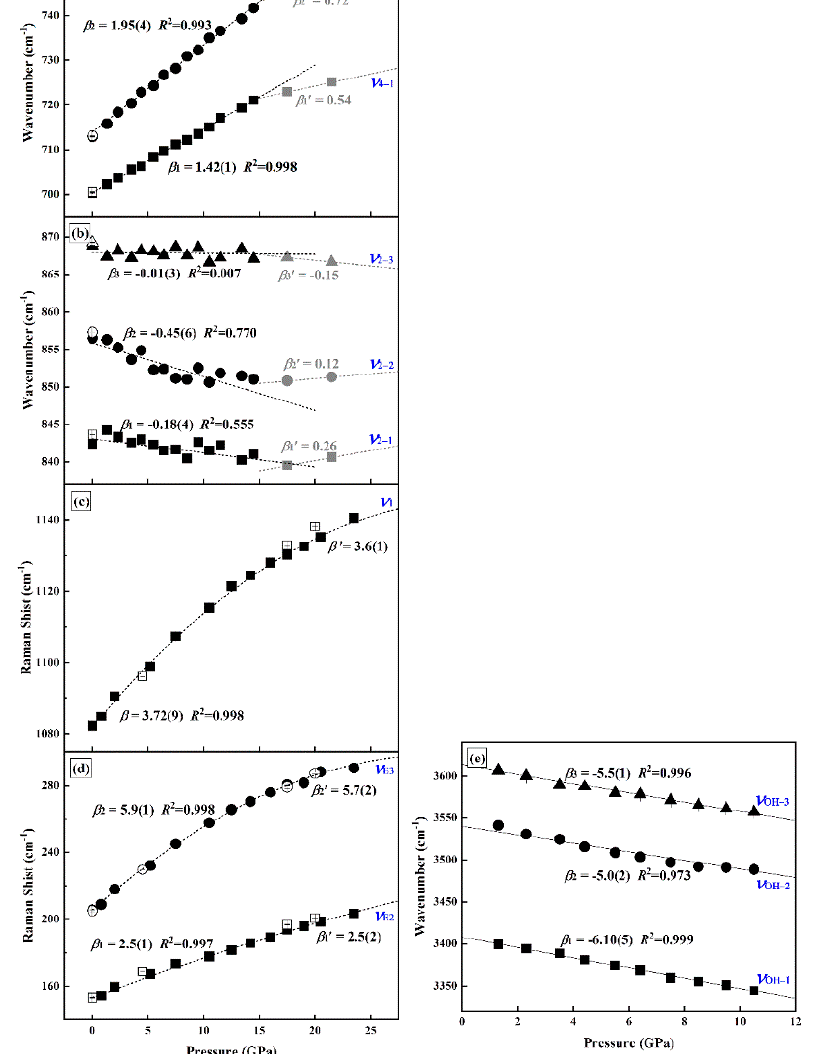
Figure 5. Mode wavenumbers versus pressure plot for aragonite. The relations in ( a ) in-plane O-C-O bending modes, ( b ) out-of-plane O-C-O bending modes and ( e ) the stretching vibration of OH are derived from the infrared spectra and in ( c ) O-C-O symmetrical stretching vibration and ( d ) O-C-O asymmetric stretching vibration from the Raman data. The closed/open symbols denote data measured during the upward/downward cycle of pressure. Symbol size generally exceeds the estimated standard deviations of the mode wavenumber. The dotted curves are the least square fittings to the data.